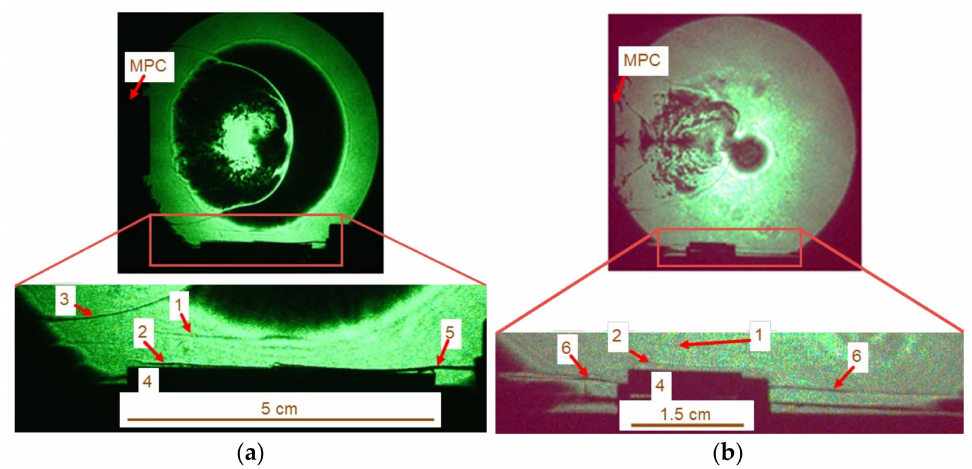
Figure 2. Waveforms of discharge current (red) and photodiode signal (blue).